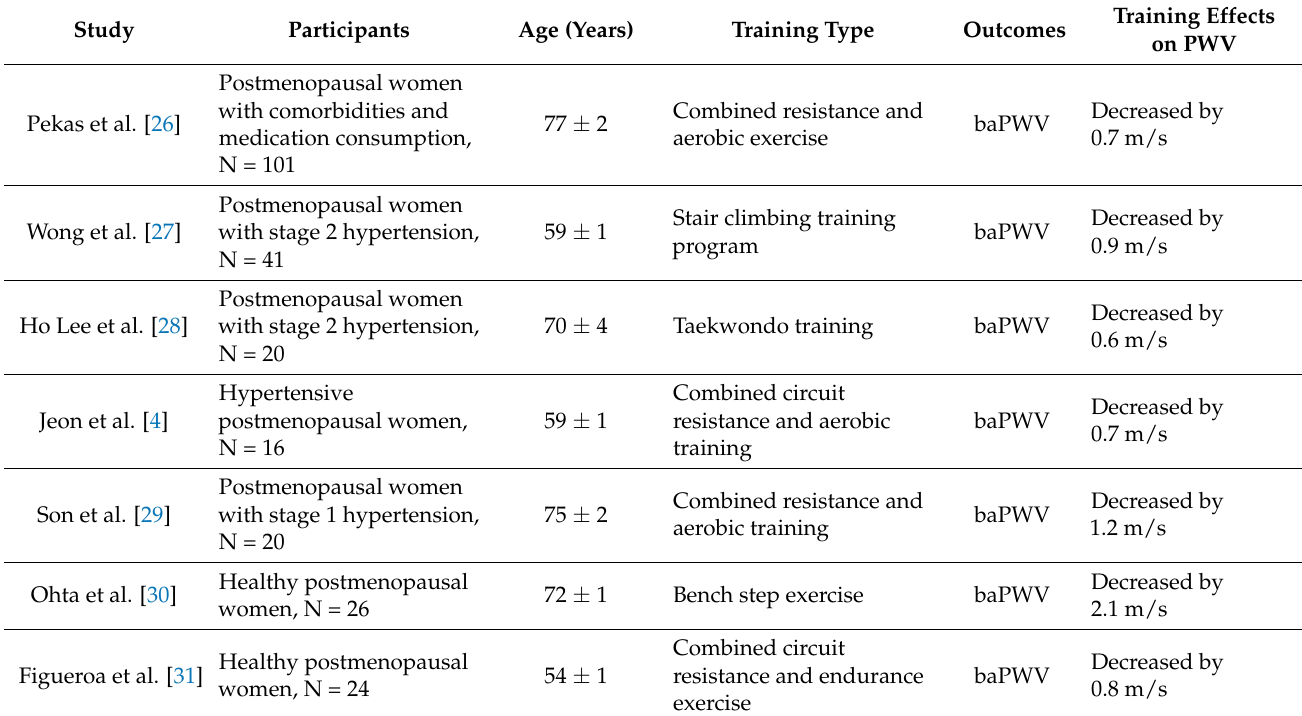
Table 2. Characteristics of included